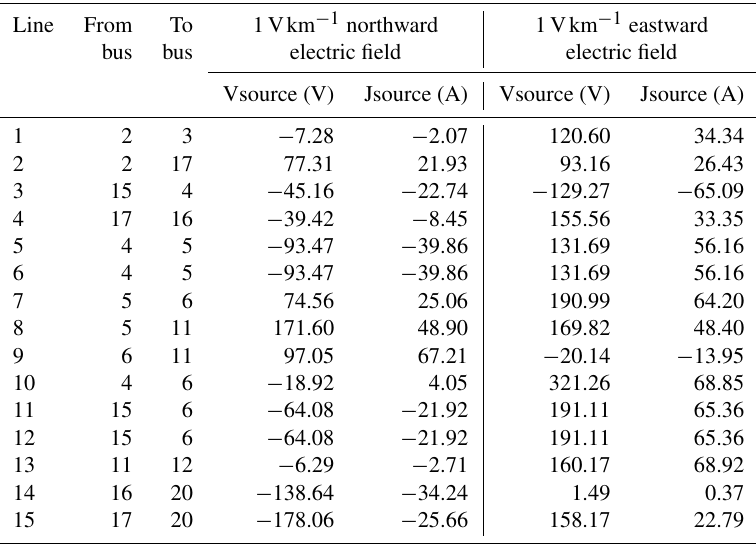
Table 5. Voltages in the transmission lines and equivalent current sources for northward and eastward electric fields of 1Vkm − 1 .